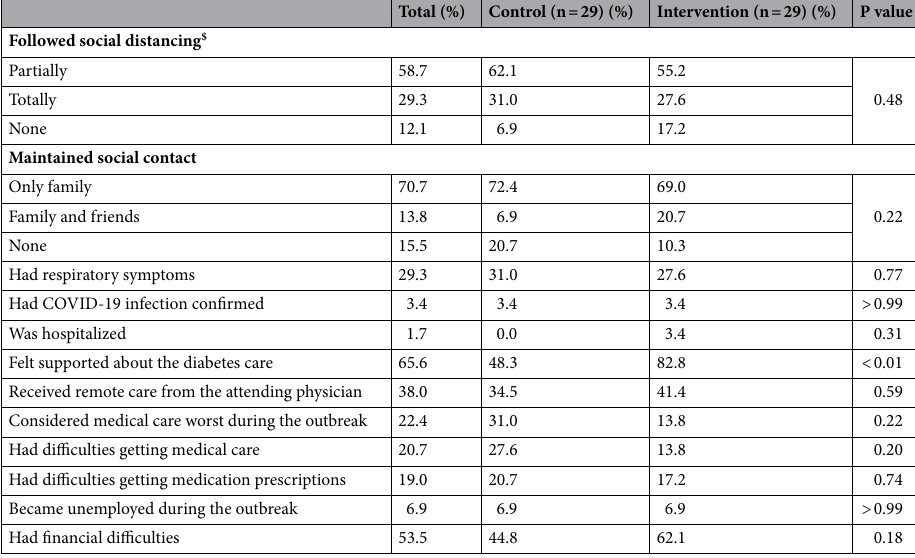
Table 2. Assessment of clinical, psychosocial aspects and perceptions about diabetes care after 16 weeks of follow-up during the COVID-19 outbreak. Data are %. α ≤ 0.05 indicates significant difference. $ Partial social distancing includes patients who left home only for basic activities, such as market, pharmacy and health care. Total social distancing includes patients who followed the orientation of home-staying